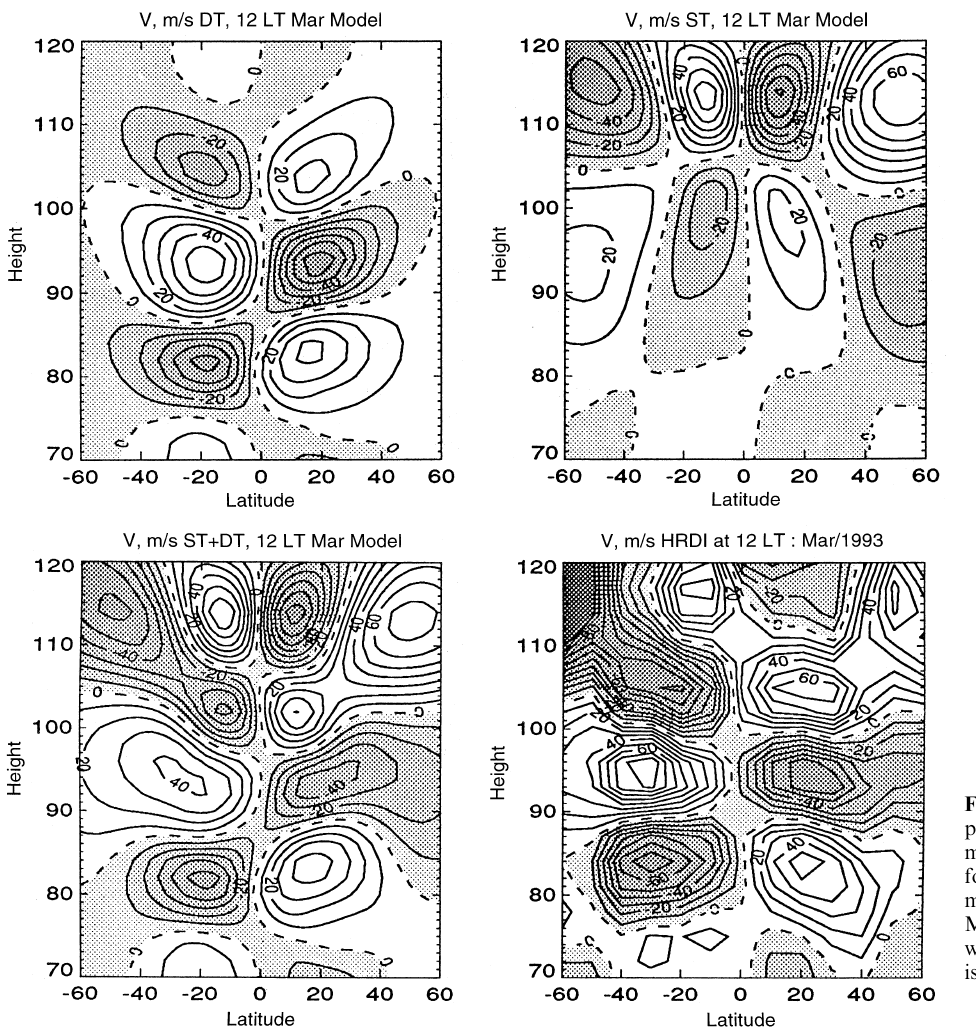
Fig. 1. Meridional winds predicted by mechanistic tidal model results (without tuning) for March, and the HRDI meridional wind observations for March 1993 at 12 LT. Southward winds are shaded ; dashed contour is the zero